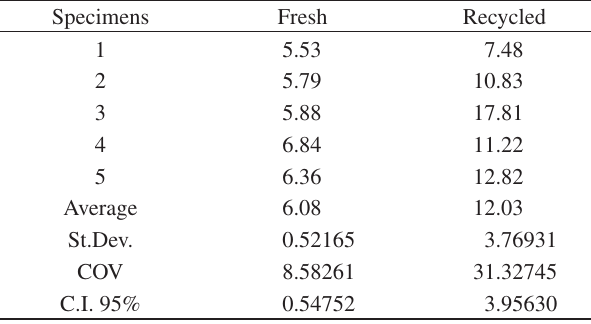
Table 1. Polyester Fresh and Recycled Test Results.